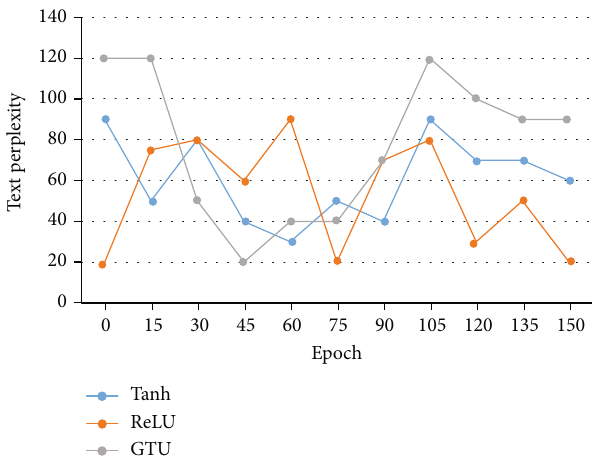
Figure 7: Curve of accuracy during training. Table 2: Correlation of evaluation